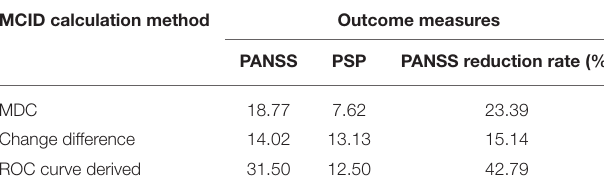
TABLE 3 | MCID threshold values for PANSS, PANSS reduction rate, and